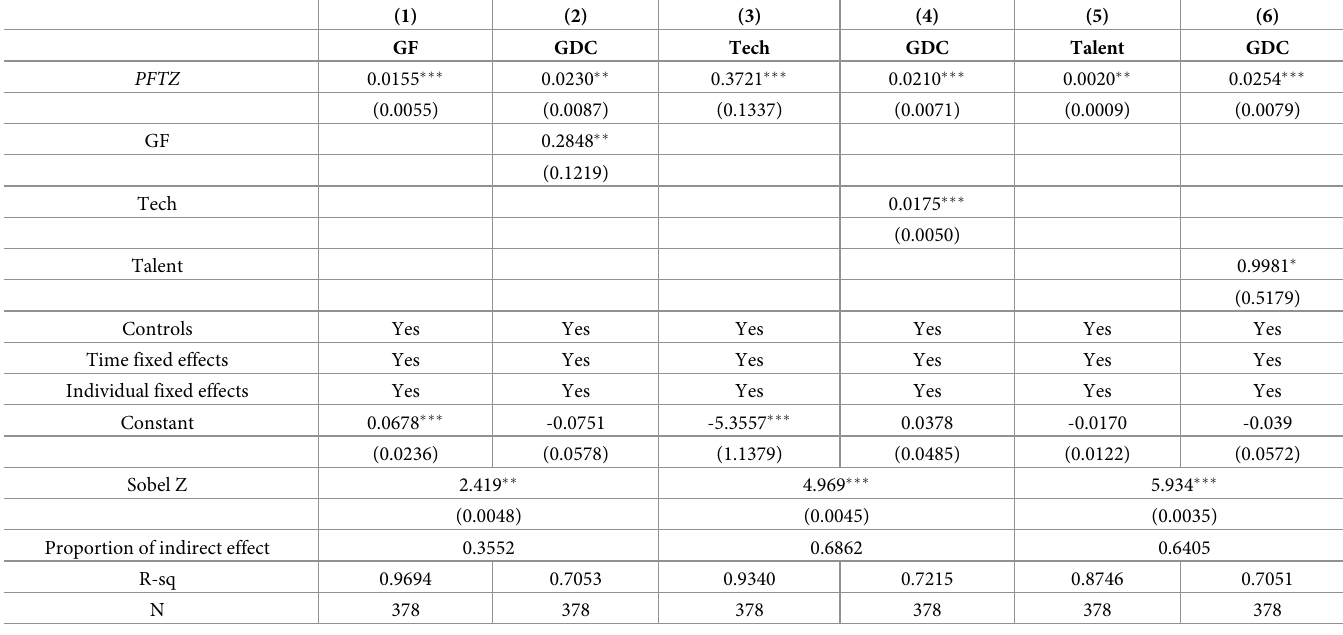
Table 9. Results of transmission mechanism